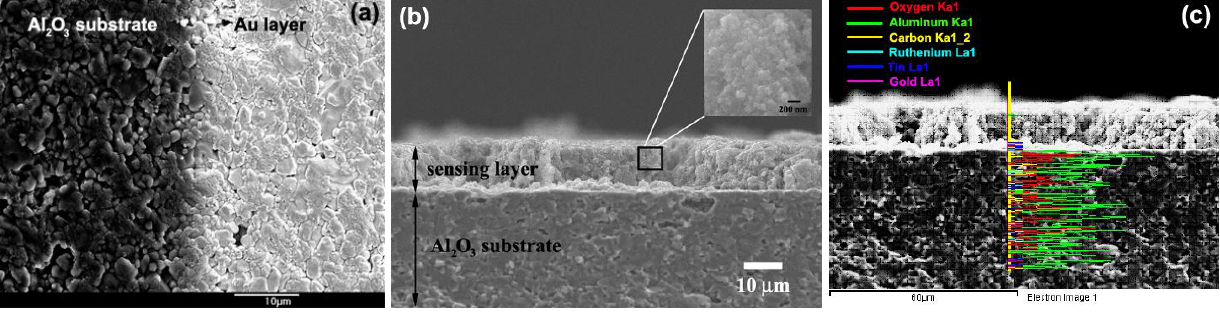
O (dark view, 2 3